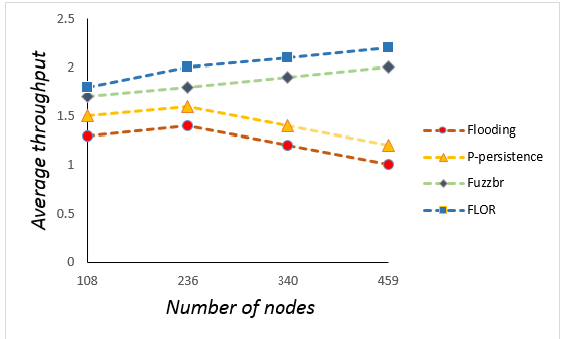
Figure 11. Network throughput for different numbers of vehicles.